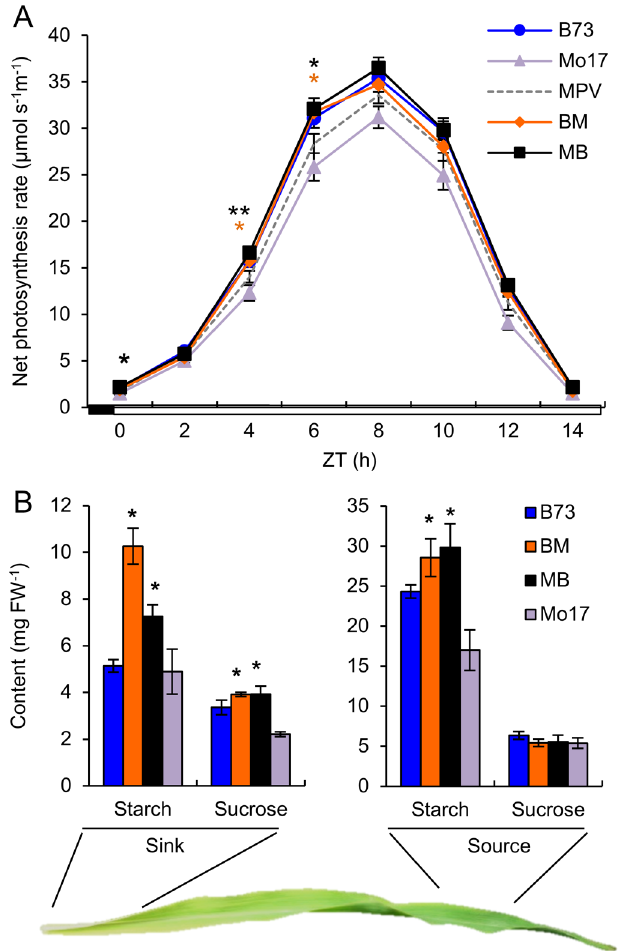
Fig 2. Increased capacity of carbon fixation in the F1 hybrids relative to the inbreds. (A) Diurnal rhythms of net photosynthesis rate in the maize inbreds and hybrids (means ± SEM, n = 9). (B) Starch and sucrose accumulation in sink and source regions of a mature leaf (means ± SEM, n = 3) at ZT14. FW, fresh weight. Significant difference between hybrids and MPV was calculated using Student ’ s t-test, * p- value < 0.05 and ** p-value <